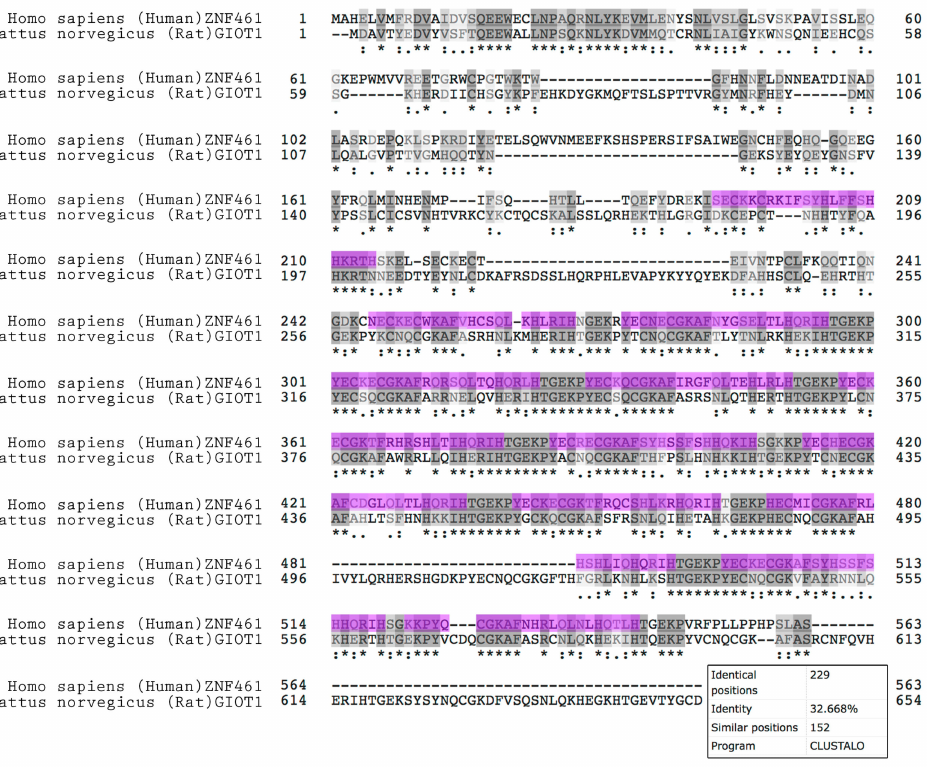
Figure 11. Multiple sequence alignment of the following protein sequences: Homo sapiens (human) ZNF461, Rattus norvegicus (rat) GIOT1. Identical sequences are marked with a dark grey color and an asterisk. Similar sequences are indicated by a light grey color and a colon or dot depending on the degree of similarity. Conservative zinc fingers domains of human ZNF461 were marked in